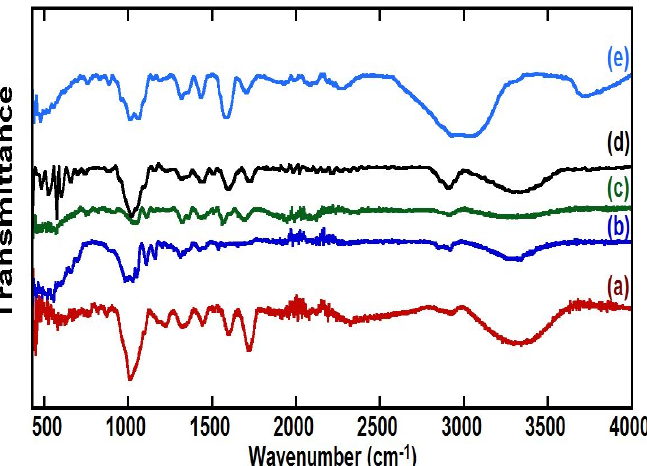
Figure 1. FTIR of ( a ) dried and ground pomegranate peels (PPs), ( b ) pomegranate peels after basic treatment (BPPs), ( c ) after hydrothermal carbonization treatment (HTC-HC), ( d ) after microwave- assisted hydrothermal carbonization treatment (HC) and ( e ) after microwave-assisted hydrother- mal carbonization treatment in the presence of ZnCl 2 (AHC).